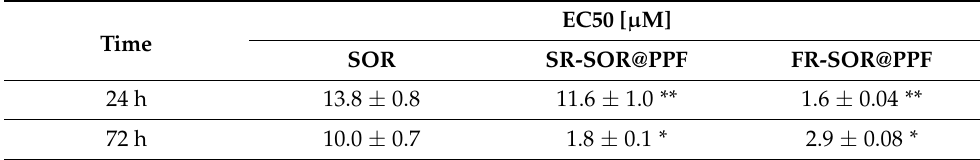
Table 1. Effective concentration (EC50) for anti-proliferative activity of sorafenib and SR-